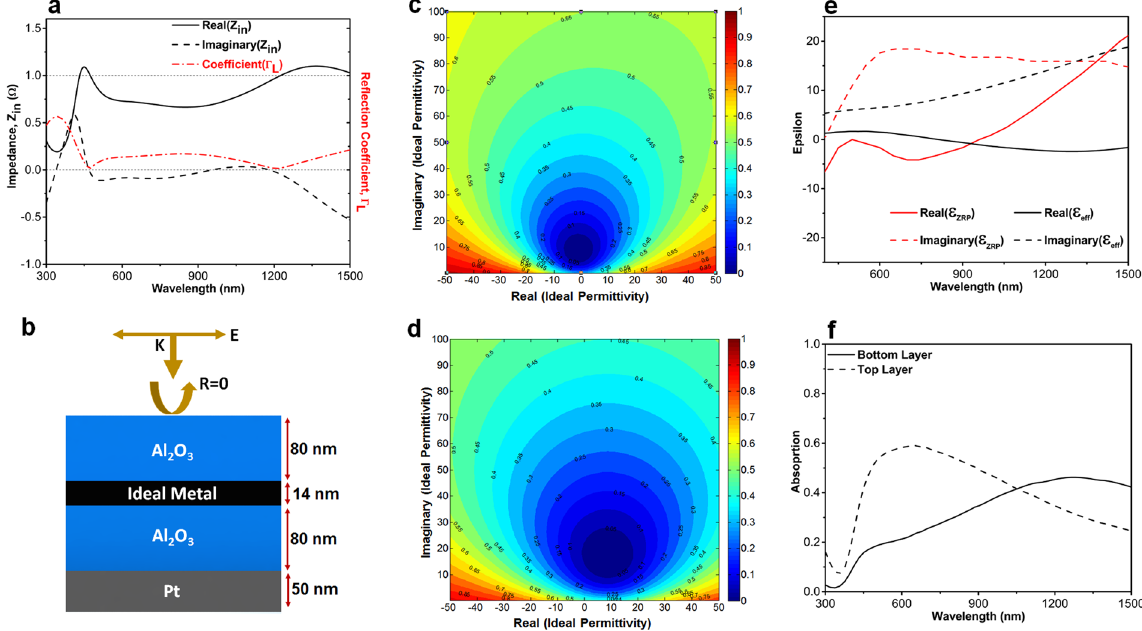
Figure 6. ( a ) The extracted input impedance and reflection coefficients for the non-uniform textured design with D B = 1 nm and D T = 14 nm. ( b ) Illustrative cross sectional view of the setup to find permittivity values for middle ideal metal layer and corresponding reflection contour plots for reflection values of the MIMI multilayer as a function of real and imaginary parts of permittivity at ( c ) 470 nm and ( d ) 1225 nm. ( e ) Extracted real and imaginary parts of permittivity for our nonuniform textured design and zero reflection point (ZRP) of ideal perfect absorber. Part ( f ) demonstrates the total absorption amount at the bottom (manitor A) and top (manitor B) metal layers as a function of excitation